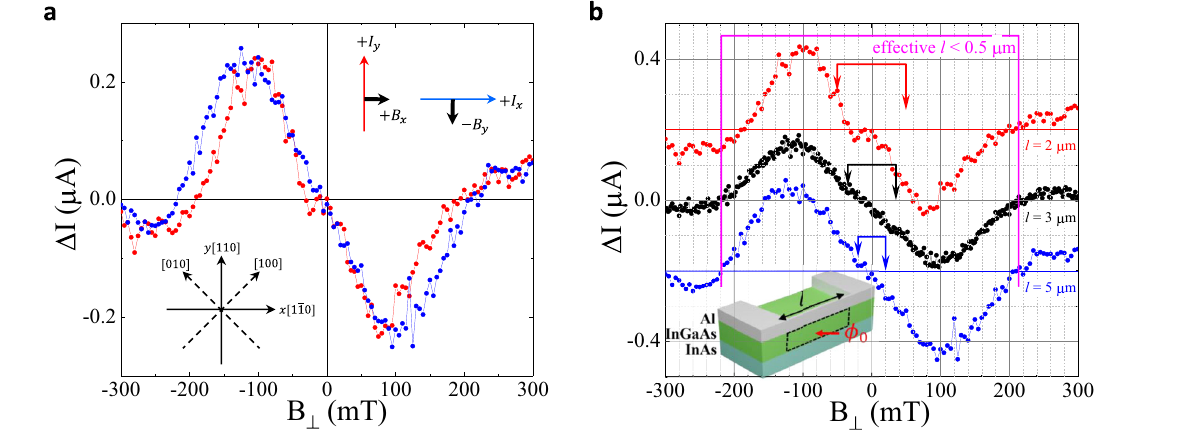
dependenceofaverage values h I + sw i and h I (cid:1) sw i isplottedinFig.1bforthe